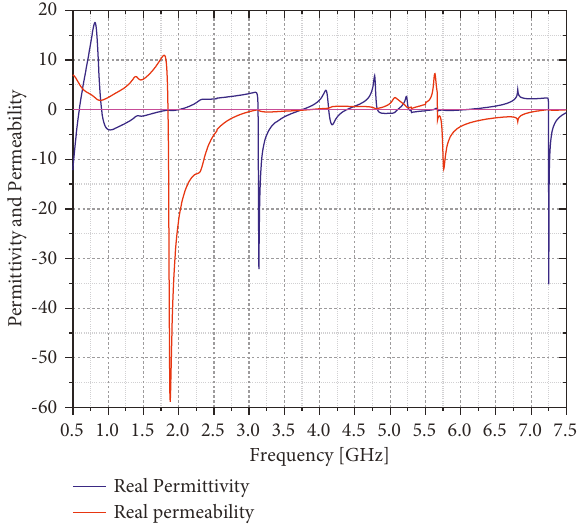
Figure 7: Retrieved real effective permittivity and permeability of the DSCSSRs. Table 2: Extracted real permittivity and permeability